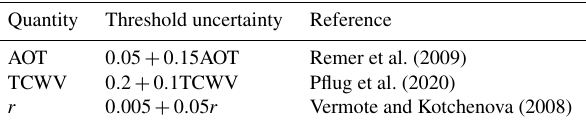
Table 1. Threshold uncertainty specifications for aerosol optical thickness (AOT), total column of water vapour (TCWV), and BOA BRF ( r ) used in this